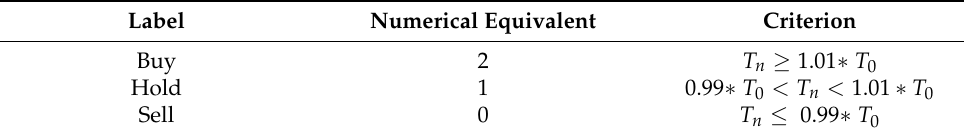
Table 2. Criteria for Labels.